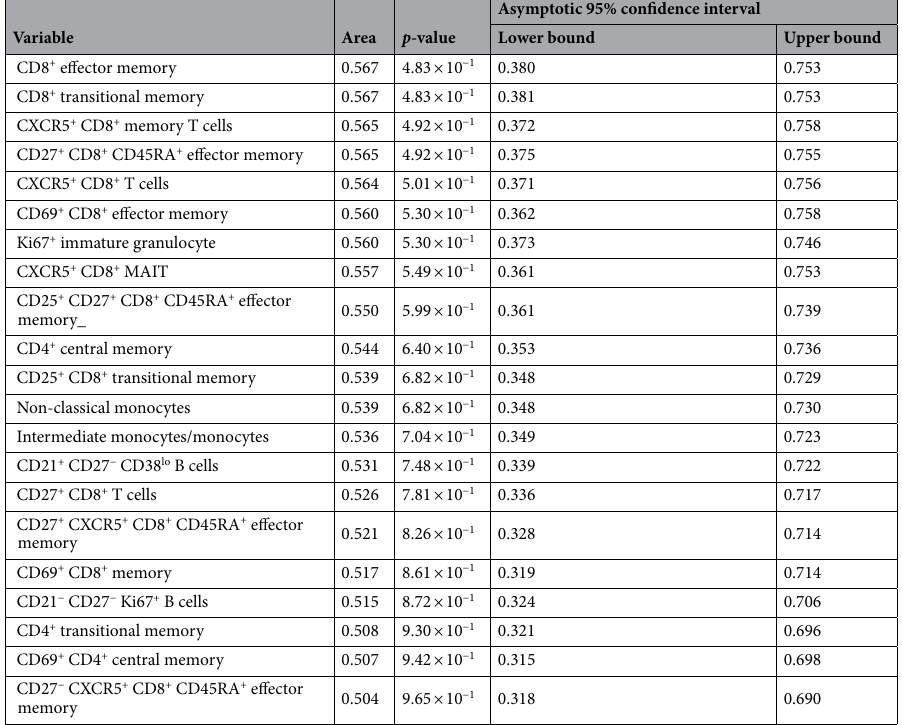
Table 6. Estimating the predictive ability of individual biomarkers in identifying severe COVID-19 patients in a population composed of uninfected participants as well as COVID-19 patients with either moderate or severe disease using the area under a receiver operating characteristic curve (AUC) method. Shown p -values are corrected for multiple testing using Holm method. Cell populations are expressed as percentages of their respective parent populations except for where mean fluorescence intensity (MFI) is indicated.